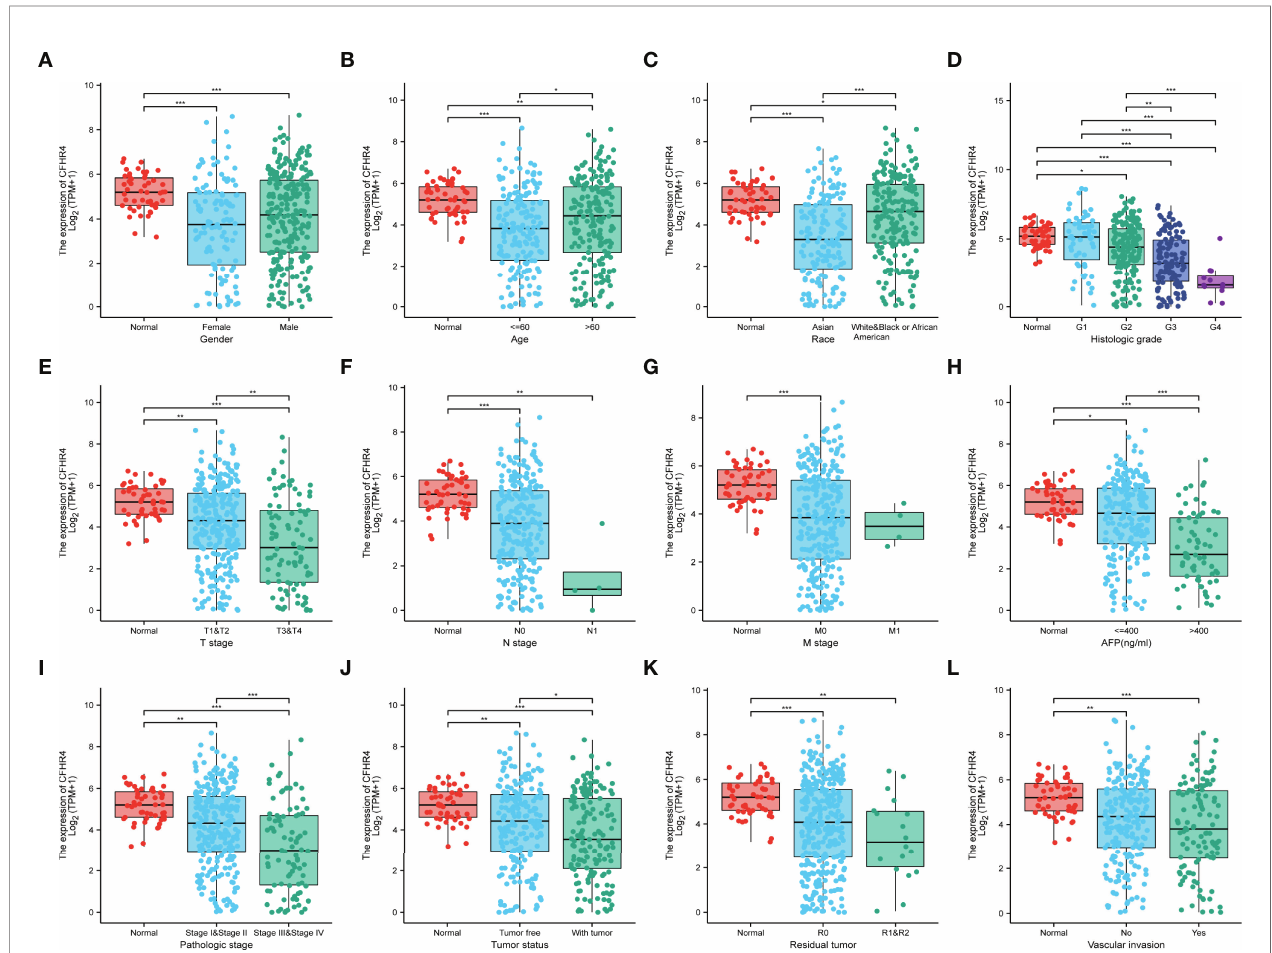
FIGURE 5 | Correlation of CFHR4 expression with clinicopathological characteristics. (A) Sex. (B) Age. (C) Race. (D) Histologic grade. (E) T stage. (F) N stage. (G) M stage. (H) AFP level. (I) Pathological stage. (J) Tumor status. (K) Residual tumor. (L) Vascular invasion. *p < 0.05, **p < 0.01, ***p <